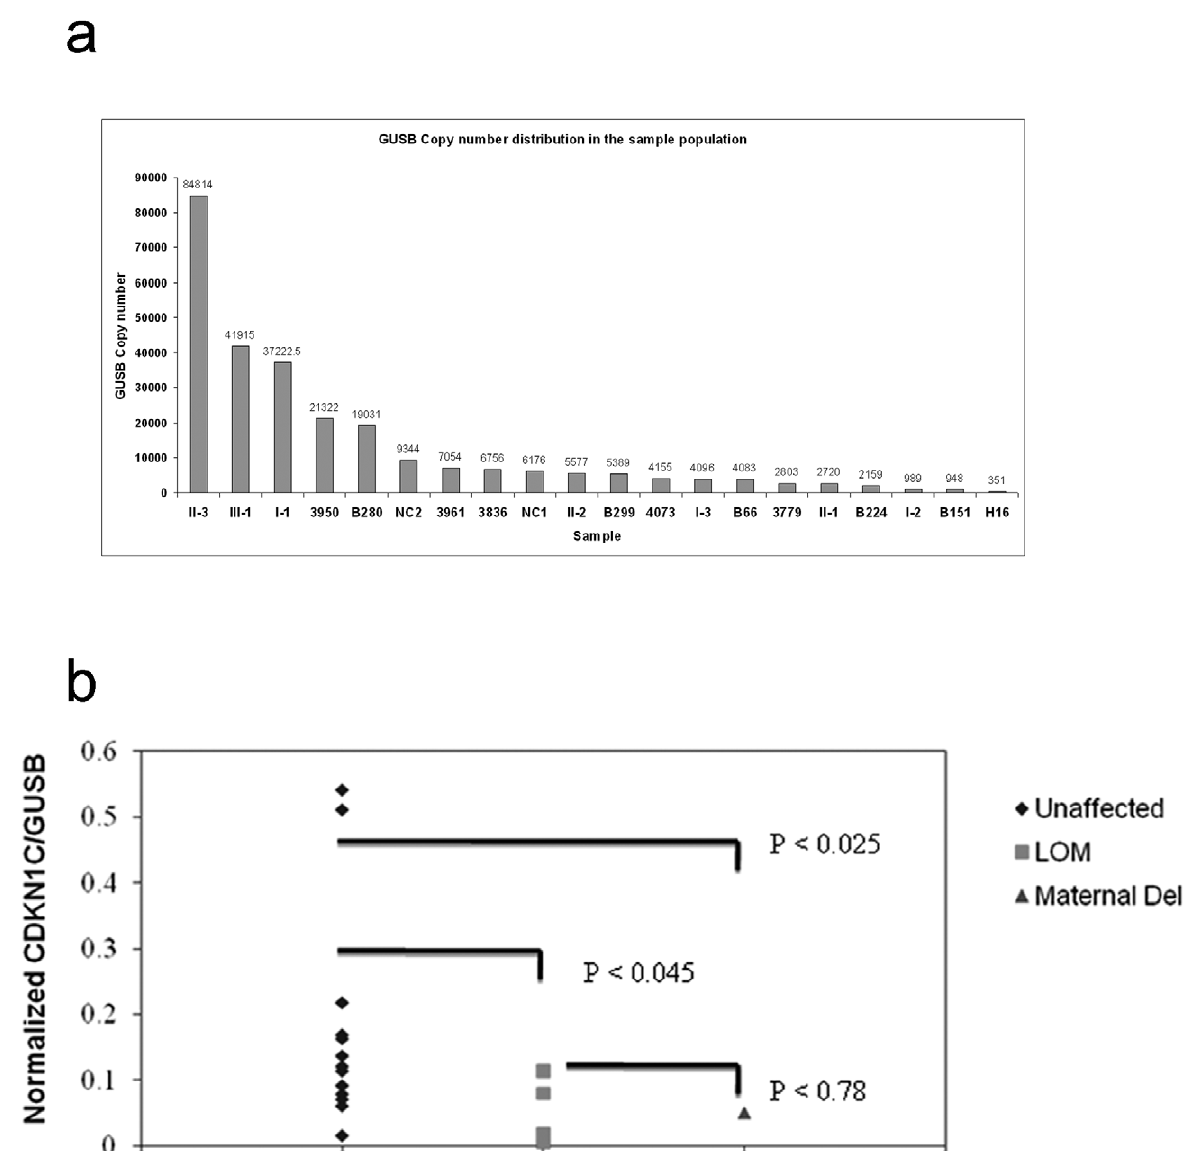
Figure 3. GUSB copy number distribution in the BWS and control population. (a) GUSB expression values were obtained from a 50 ng equivalent of total RNA. Quantitative analysis of CDKN1C expression. (b) CDKN1C expression in the blood from 12 unaffected individuals (diamonds), five BWS cases with loss of methylation at IC2 and no deletion (squares), and individuals with deletion of the maternal IC2 (triangles). The Mann Whitney non-parametric U test was used to derive the P values shown. Statistically significant P values were obtained for the population differences in CDKN1C expression between unaffected controls and cases with loss of methylation and KCNQ1/IC2 deletion.